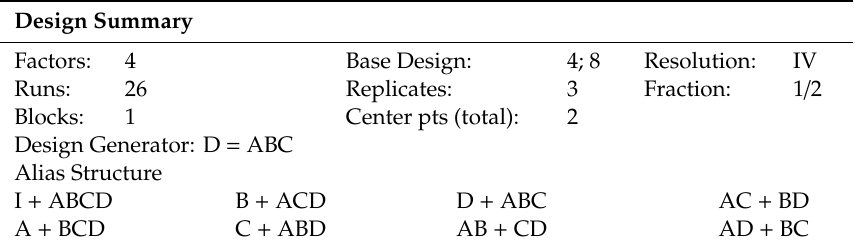
Table 6. Fractional factorial design.